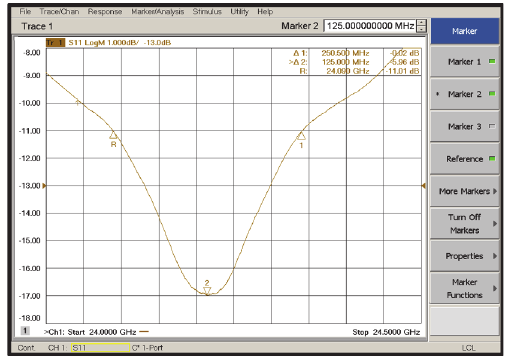
Figure 9: Measured reflection coefficient of the antenna depicted in Figure 8.